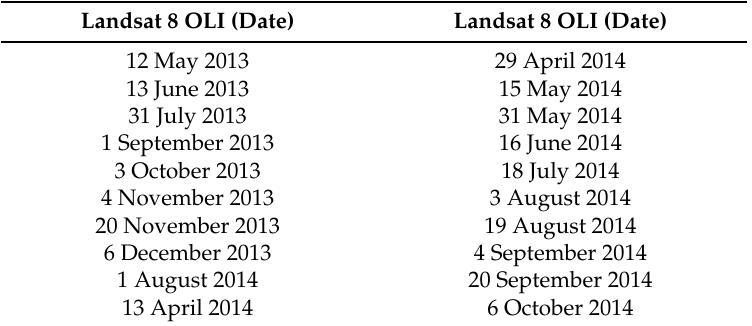
Table 2. Landsat 8 Operational Land Imager (OLI) images used for AOD retrieval.